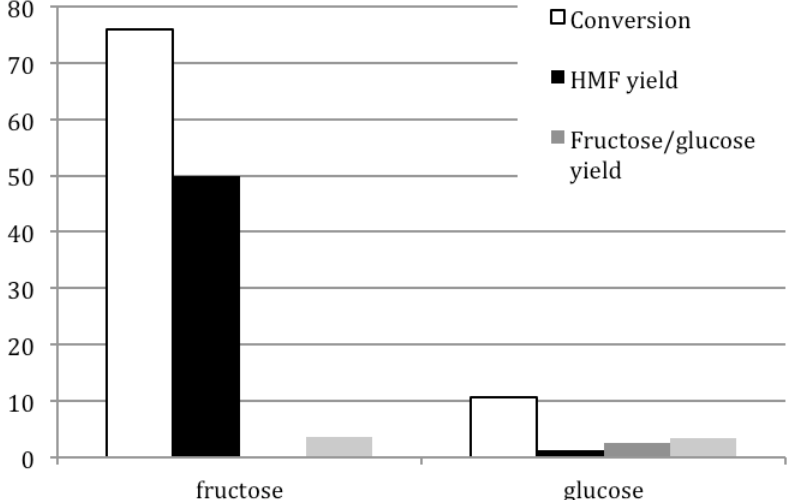
Figure 11. Glucose and fructose conversion in 5-HMF using a concentrated aqueous solution of lactic acid as reactive